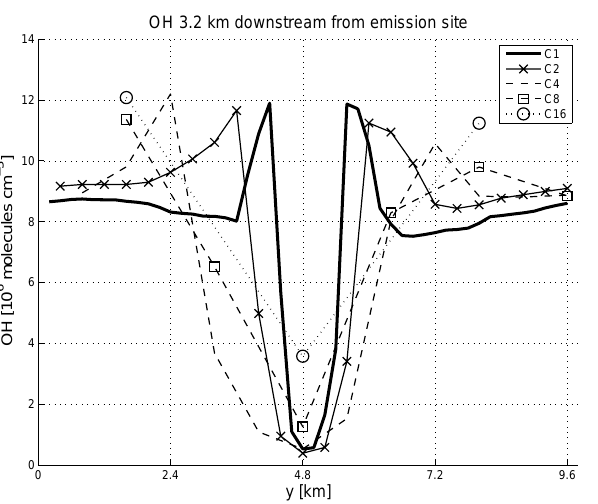
Fig. 5. Domain mean OH at noon (local time) on day 2 for dif- ferent resolutions. Dashed line represents best fit to the model re- sults C4, C8, C16 and C48. Solid markers represent our model results and hollow ones are the result of linear extrapolation of our results to larger grid box volume sizes. These larger grid box volumes represent typical CTM resolution with a boundary layer height assumed to be that of our model (1.92km). For compari- son, a “no emissions” model run produces a domain mean OH of 5.8 × 10 6 moleculescm − 3 at the same